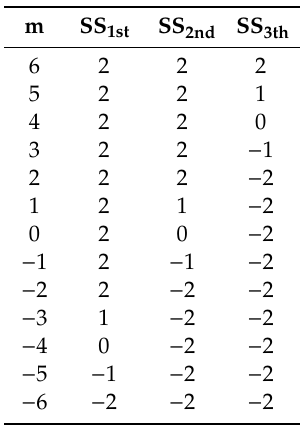
Table 2. N-Module 3LNPC Converter Switch States.